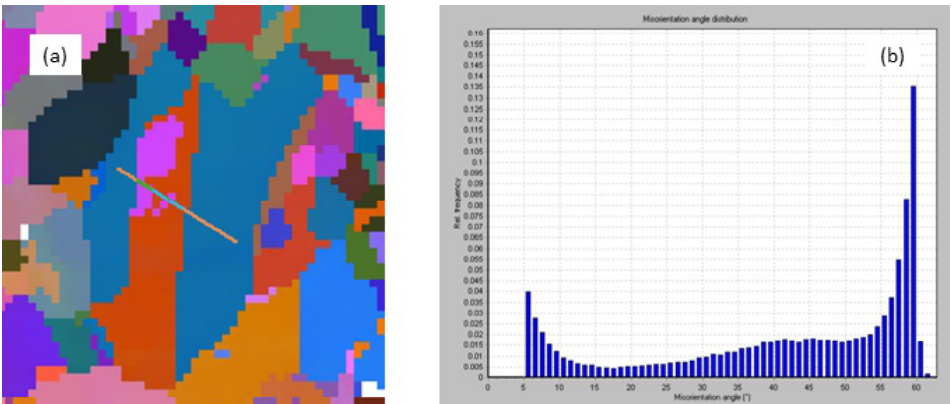
Fig. 5. EBSD data of Specimen 2 (a) IPF map of twinned trains (b) grain misorientation angles